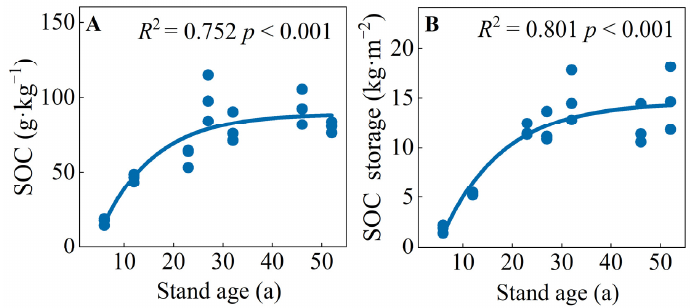
Figure 1. (A ) soil organic carbon concentrations and ( B ) storage of SOC in C. japonica plantation of different stand ages in the rainy area of western China. Across the stand ages, the ranges of POC, EOC, LOC, ROC, LFOC, and HFOC con- centrations were 0.20–4.74, 1.05–7.38, 9.04–30.55, 7.84–68.83, 1.53–27.90, and 12.38–74.93 g·kg − 1 , respectively (Figure S2). There were logistic function relationships between soil carbon fractions and stand ages (Figure 2). Specifically, the POC, EOC, LOC, and LFOC were the highest in the early over-mature forests (46 a), and the ROC and HFOC were highest in the early over-mature forest (27 a) (Figure S2). Overall, soil carbon fractions of mature and over-mature forests were significantly higher than those of young, middle- aged, and near-mature forests (Figures 2 and S2).